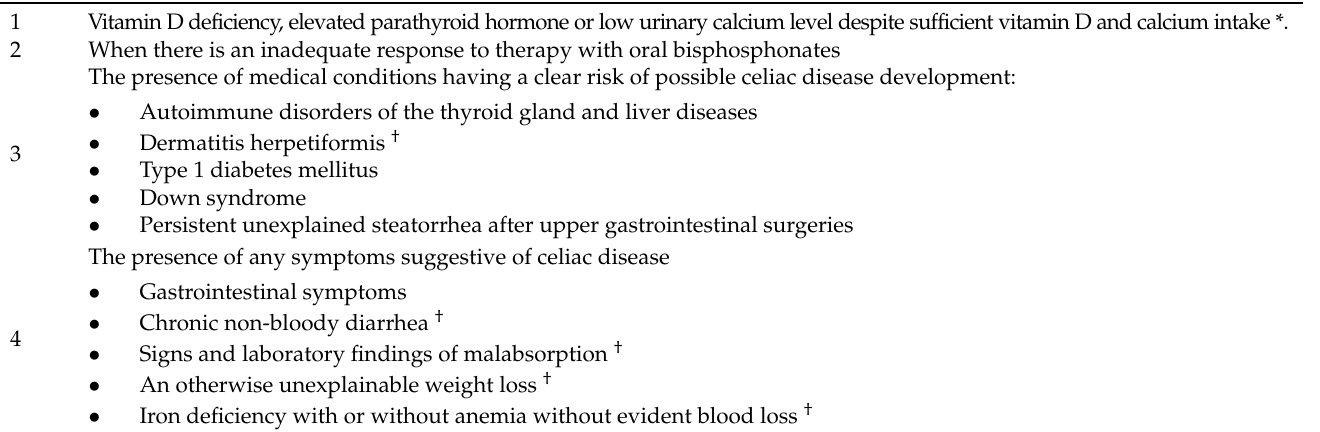
Table 1. The scenarios for CeD screening in individuals having fragility fracture or low